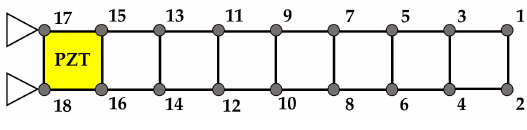
Figure 5. Piezo-beam discretized model. Table 3. Beam natural frequencies (reduced model